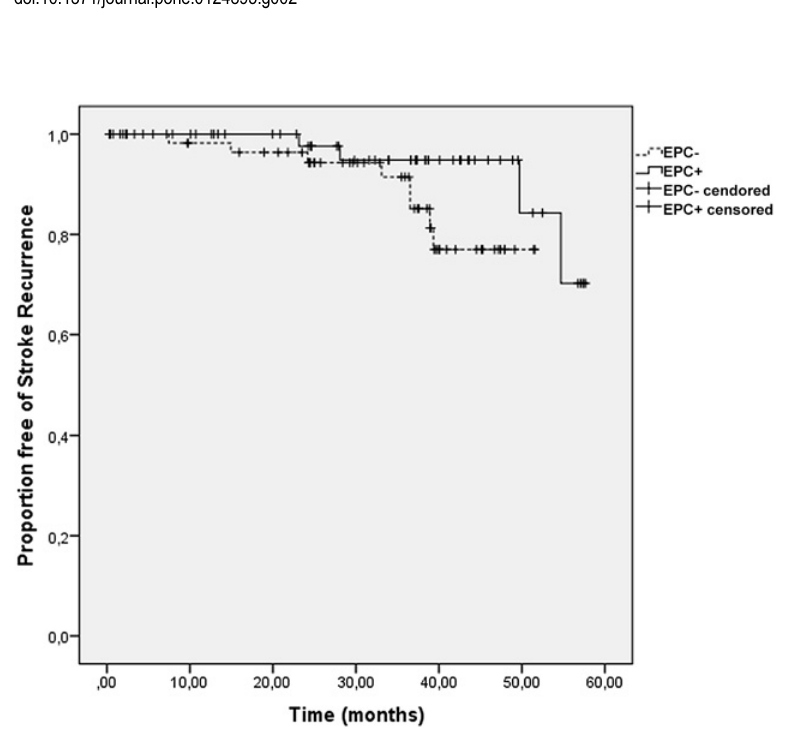
Fig 3. Kaplan-Meier Survival Curves for Stroke Recurrence in Patients with (EPC+) and Without (EPC-) Circulating EPC. Result of the Log-rank test Comparing Both Groups, p = 0.104.